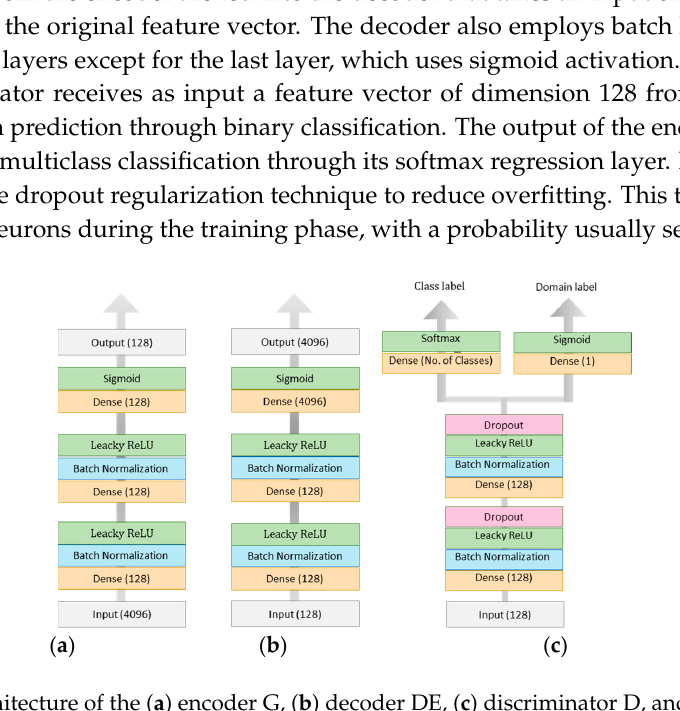
Figure 5. Architecture of the ( a ) encoder G, ( b ) decoder DE, ( c ) discriminator D, and classifier CL.